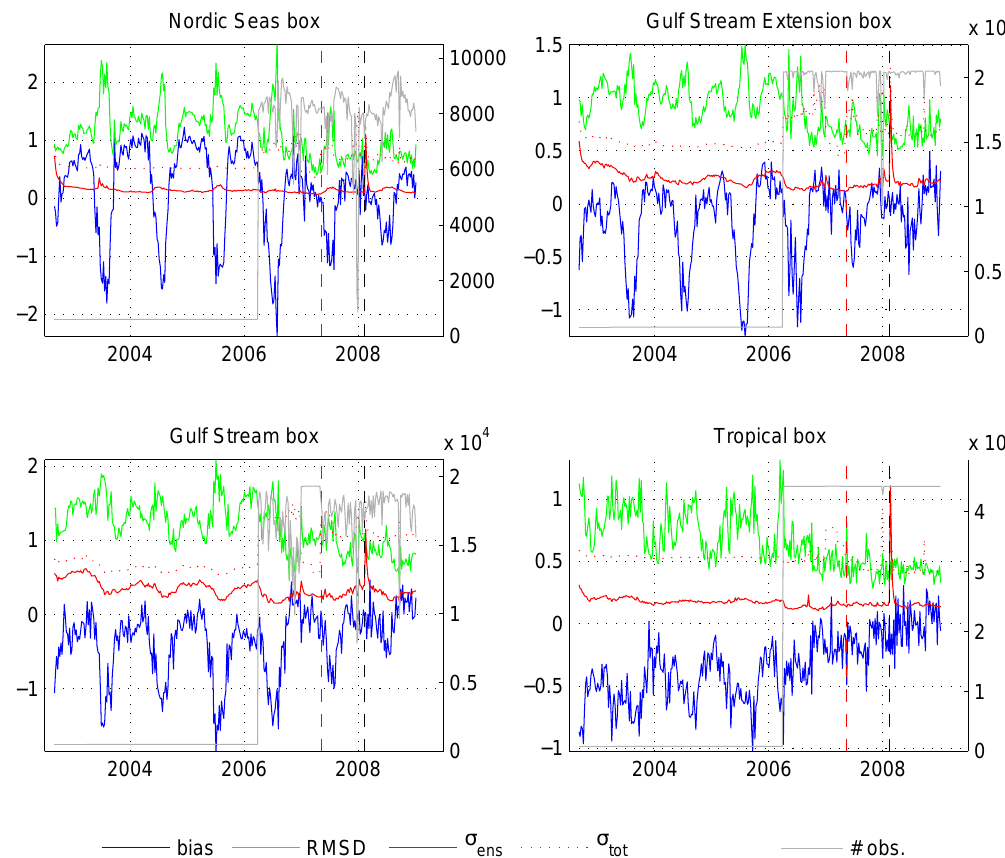
Fig. 6. Innovation statistics for SST (see description in caption to Fig. 5). The Arctic region is not represented because there are no remote SSH observations